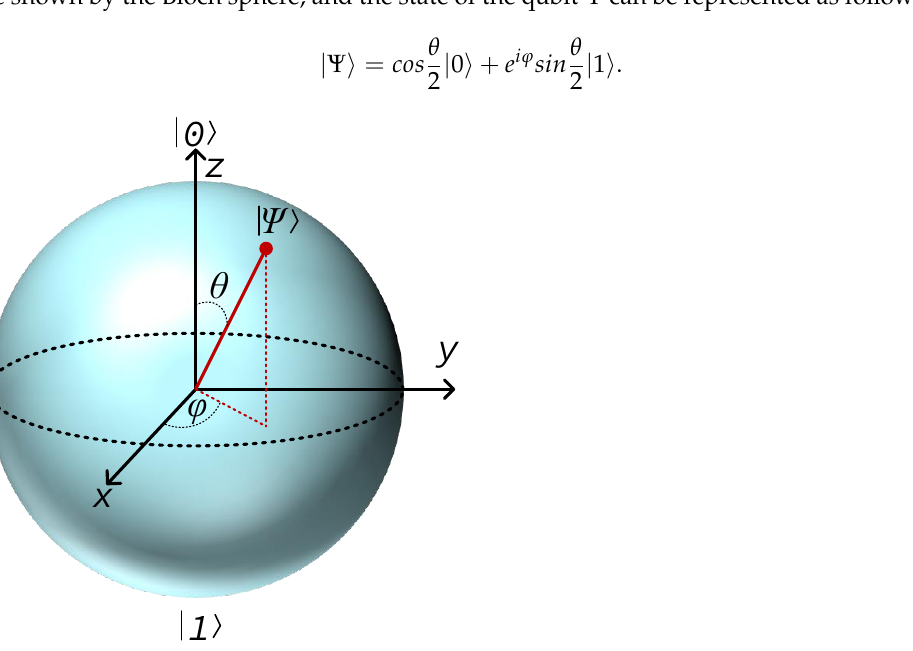
Figure 1. Visualization of the state of a qubit Ψ in the Bloch sphere (more details can be found in